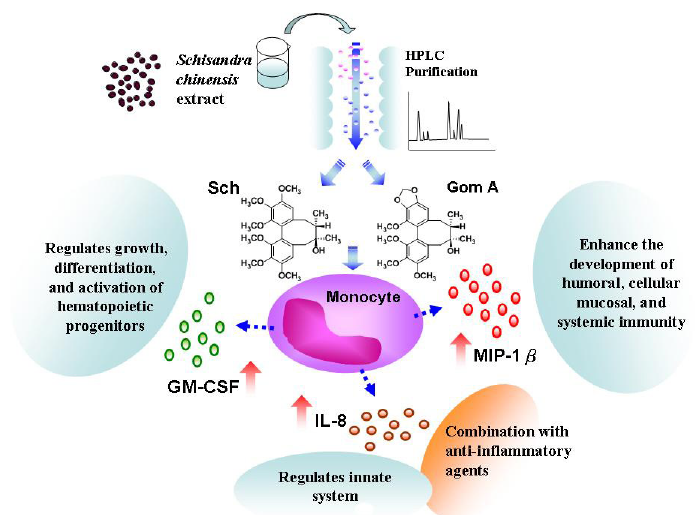
Figure 5. Putative immuno-regulatory effects of S. chinensis and its constituents on THP-1